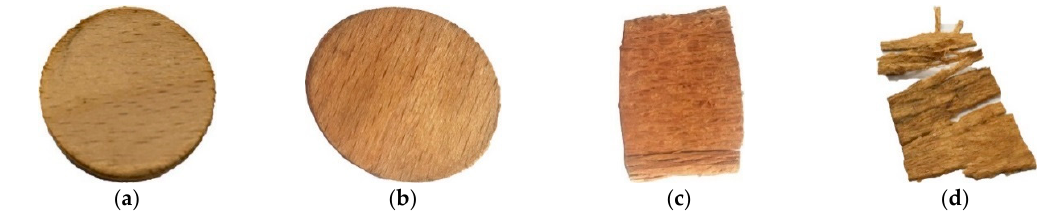
Figure 11. Final failure shapes of DTRD under different strain rates of ( a ) 800 s − 1 , ( b ) 1200 s − 1 , ( c ) 1800 s − 1 , and ( d ) 2000 s − 1 . Forests 2019 , 10 , x FOR PEER REVIEW